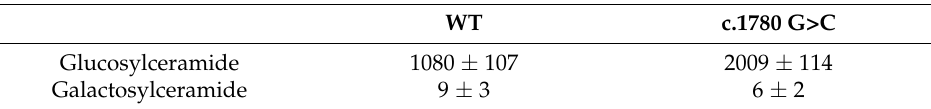
Table 1. Hexosylceramides of lymphoblastoid cell lines (LCLs) from controls and patients. Glucosylceramide (GlcCer) and galactosylceramide (GalCer) contents were evaluated by SFC-MS/MS in controls (WT, n = 4) and patients (c.1780G>C, n = 3) LCLs. Data are expressed as pmoles/mg of cell protein ± Error ( n = 3).